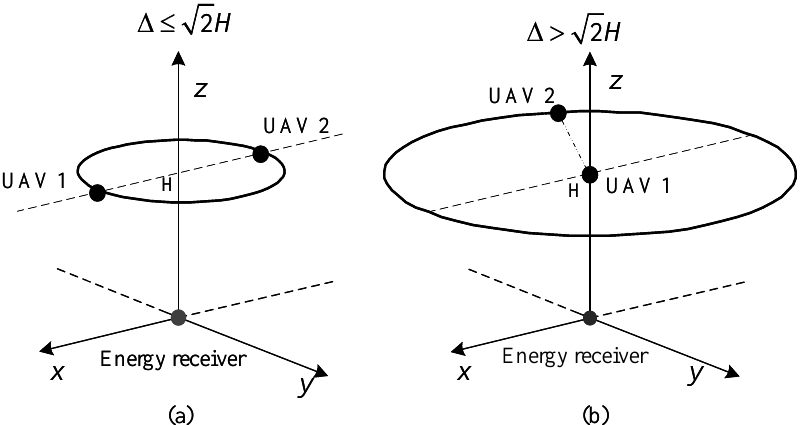
Figure 2. The optimal trajectory of UAVs in the scenario of K = 1 and M = 2. ( a ): the locations of the UAV when the safe distance ∆ ≤ √ ∆ > 2 H